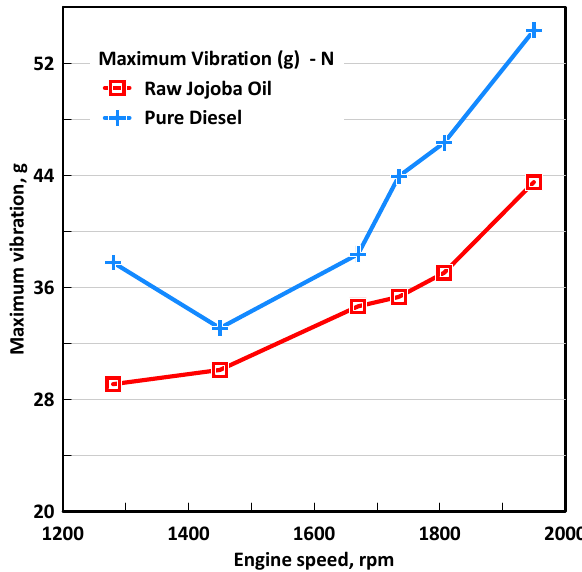
Figure 16. Maximum vibration amplitude for the ensemble-averaged cycle.